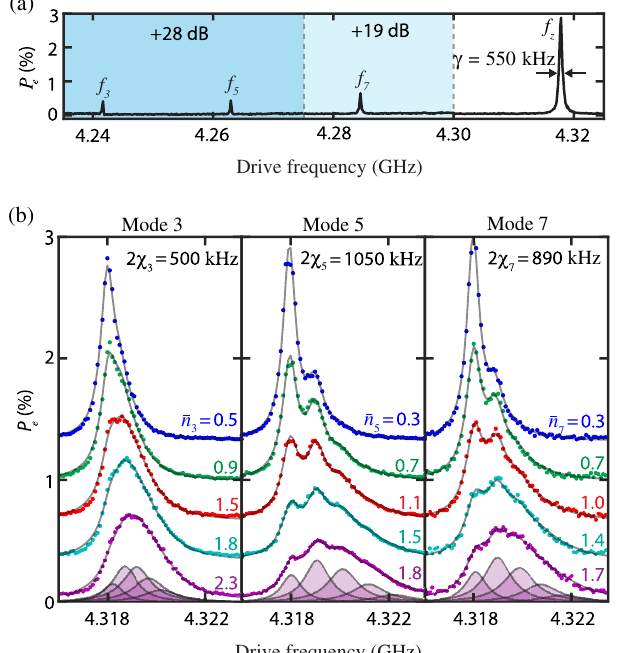
¼ FIG. 4. Phonon number splitting. The qubit is tuned to f z 4 . 318 GHz where no resonant interactions occur and the first two transmon transitions straddle the acoustic modes. (a) To excite and measure the acoustic modes, the drive power is increased relative to the power used near the qubit transition (shaded, þ 19 or þ 28 dB). The interactions with all acoustic modes are dispersive, with Δ 3 =g 3 ¼ 18 , Δ 5 =g 5 ¼ 11 , and Δ 7 =g 7 ¼ 8 . 5 . (b) While driving the strongly coupled acoustic modes (3, 5, and 7), we observe the qubit transition broaden and shift up in frequency with increasing phonon population. The spectra are fit to a model assuming a coherent state with ¯ n average phonons to m determine χ . For modes 5 and 7, the measured single-phonon m Stark shift exceeds both the qubit and acoustic linewidths. Traces are vertically offset to aid clarity. For the trace in each mode with the highest phonon occupancy, the contributions to the best fit from each phonon Fock state are shown (shaded